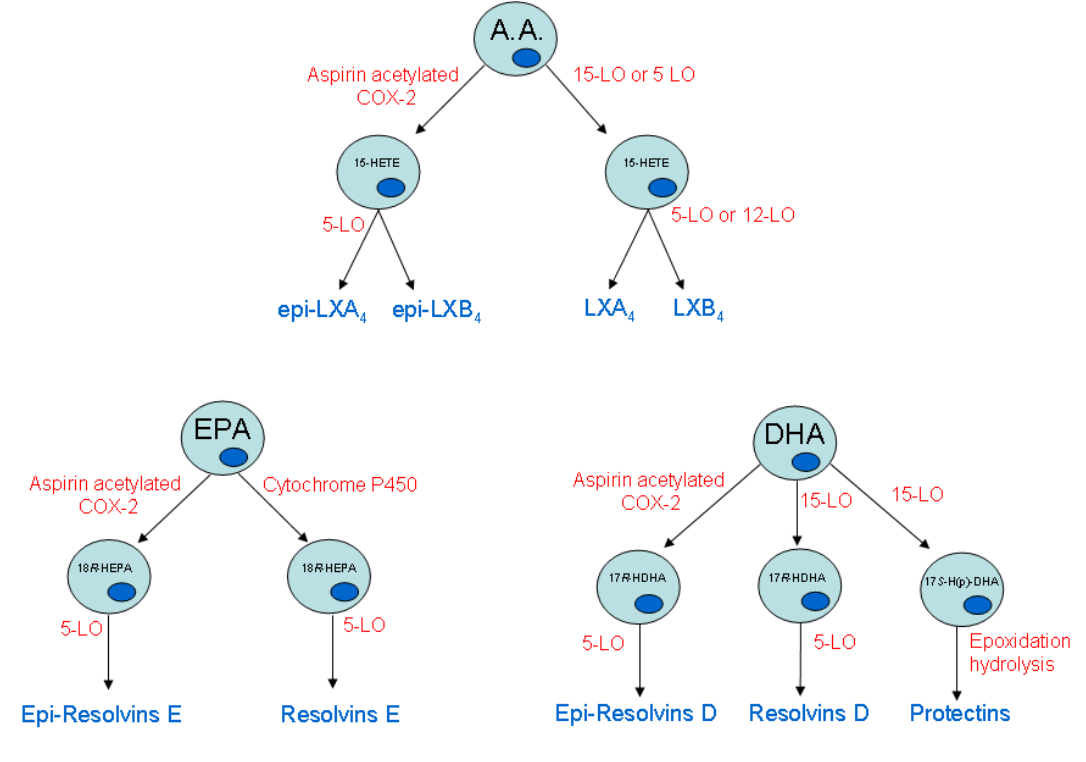
FIGURE 2. Biosynthesis of lipoxins, resolvins, and protectins. Lipoxins (LXs) are generated from arachidonic acid (AA) in a transcellular manner involving neutrophils, platelets, and resident tissue cells, such as epithelial cells. AA is transformed by the sequential action of lipoxygenase (LO) into LXA 4 or LXB 4 with 15-hydroxyeicosatetraneoic acid (HETE) as the intermediate product[11,12]. LX formation can also be induced by aspirin, which acetylates cyclooxygenase-2 (COX-2) and thus shifts its activity from that of an endoperoxidase to a lipoxygenase and enables it to produce 15-HETE from AA, which may in turn be transformed into 15-epi-LXA 4 or 15-epi-LXB 4 by 5-LO in leukocytes[16]. Resolvins are generated from eicosapentaenoic acid (EPA) or docosahexaenoic acid (DHA). EPA can be enzymatically converted by cytochrome P450 or acetylated COX-2 into 18 R - HEPA, which can be further transformed by enzymatic epoxidation and 5-LO in leukocytes to form E series resolvins (RvE)[52]. DHA can be converted in a similar manner by the sequential activation of 15-LO or acetylated COX-2 into 17 R -HDHA, which is then transformed by enzymatic epoxidation and 5-LO to form D series resolvins (RvD)[52]. Protectins are similarly